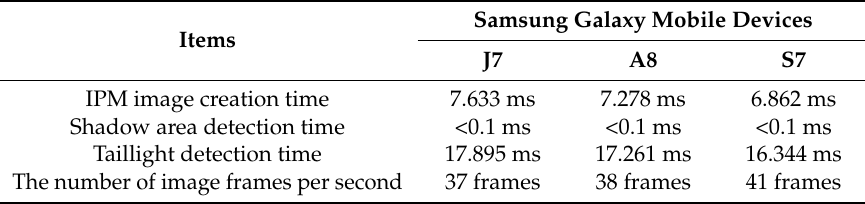
Table 1. Average image processing throughput according to smart mobile devices.